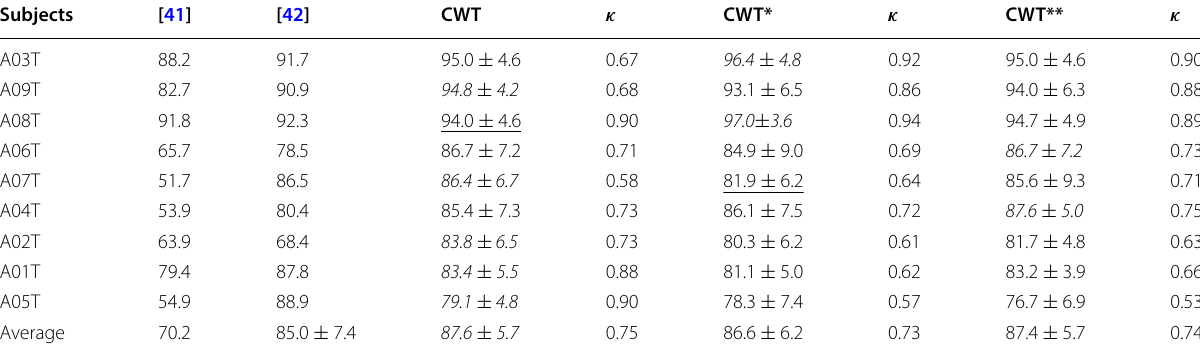
Table 3 Three-class accuracy of evaluated CNN training strategies using the CWT-extracted vectors for the considered strategies: without spatial dropping (CWT), spatial dropping by removing all sensorimotor electrodes out (CWT*), spatial dropping by excluding nonrelevant electrodes (CWT**)